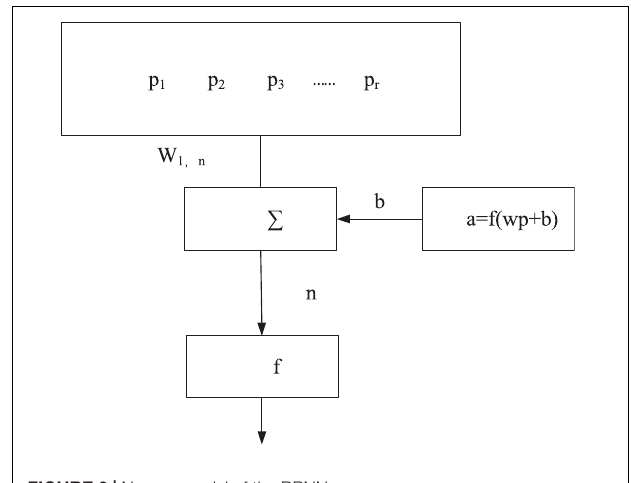
FIGURE 3 | Neuron model of the